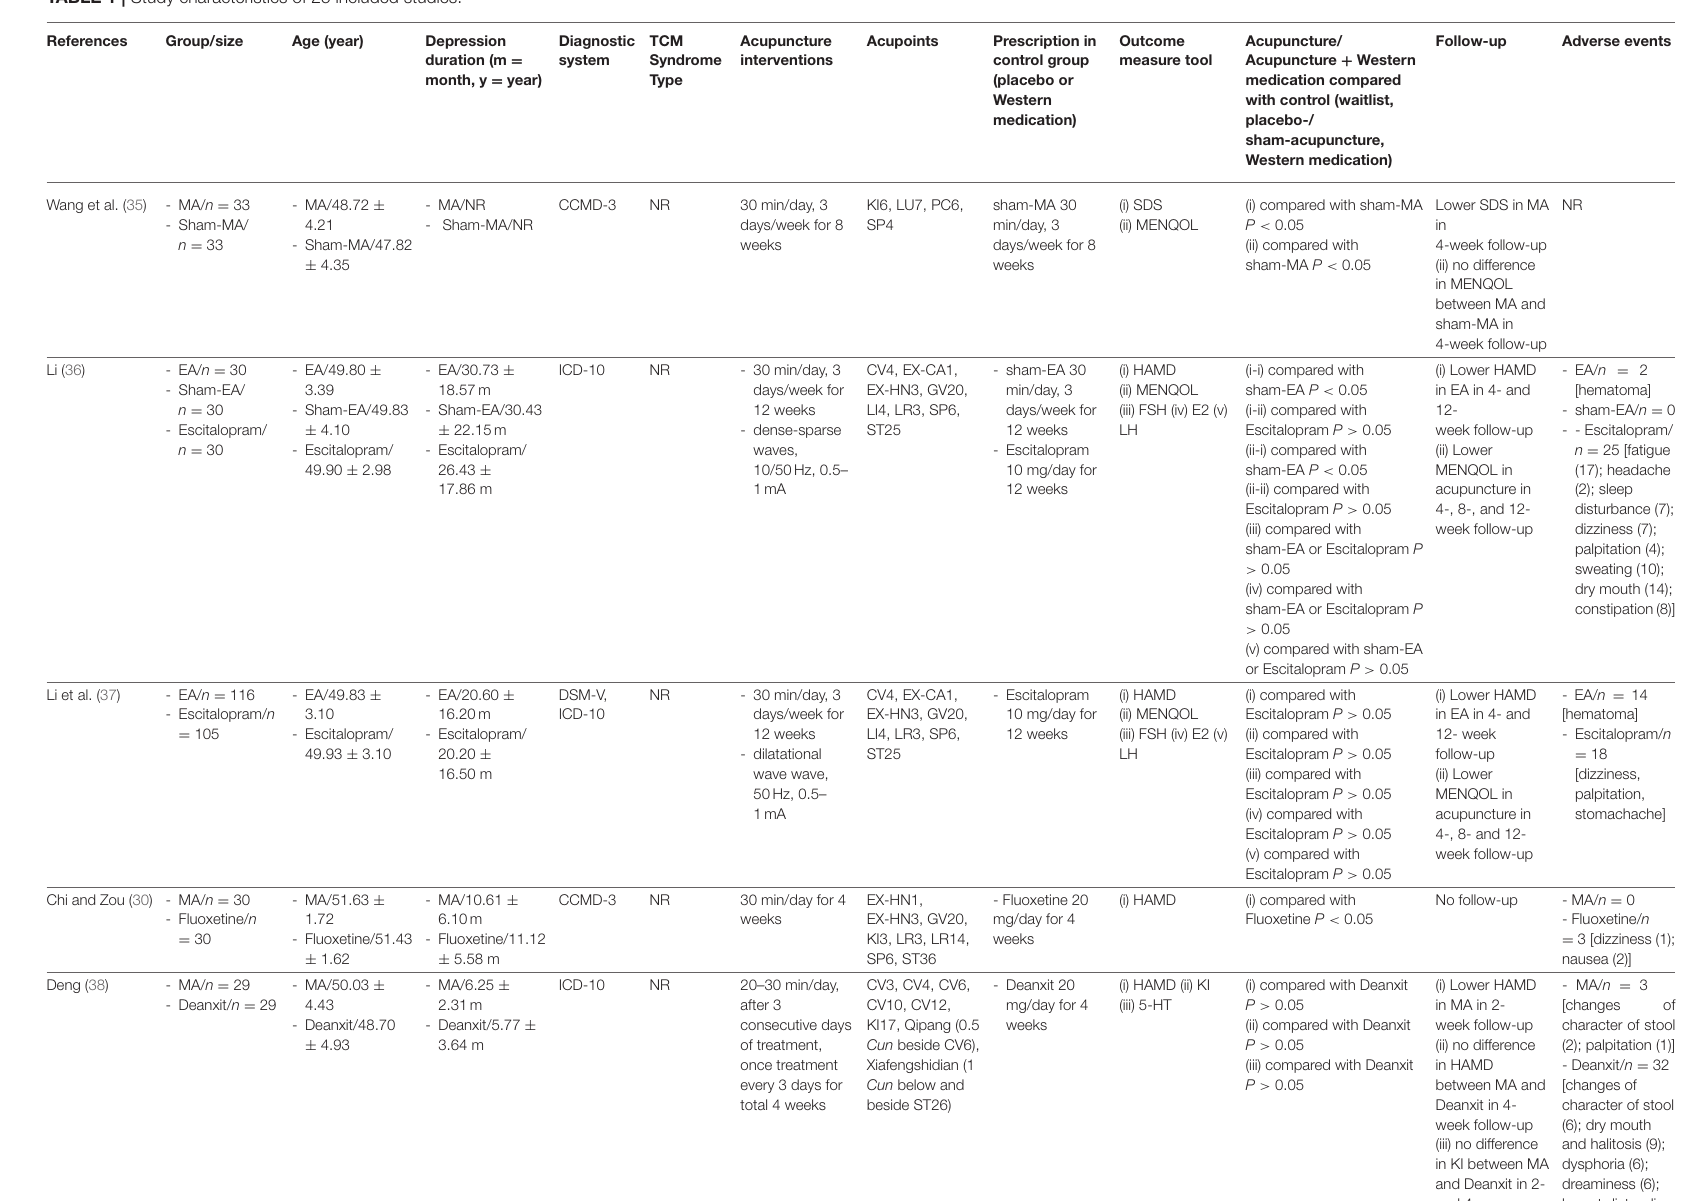
TABLE 1 | Study characteristics of 25 included